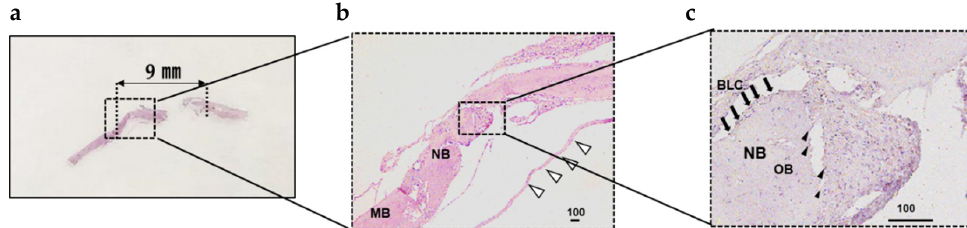
Figure 13. Histological images of the defect treated with sponges. ( a ) Created bone defect (9 mm). ( b ) Low‐magnification image. ( c ) High magnification histological image. MB: mother bone. NB: newly formed bone. OB: osteoblast (arrowheads). BLC: bone lining cell (arrows). White arrows: integrated fibrous matrix of GS. Bars: 100 μm for lowest magnification images of ( b , c ).